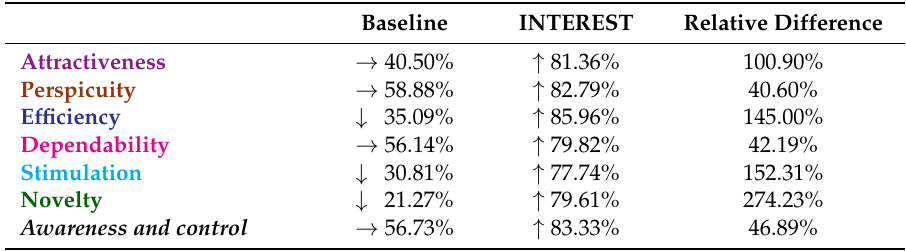
Table 6. Post-task questionnaire results in a [0, 100] scale with relative difference between Baseline and INTEREST on UX factors. The colored arrows have the same meaning as in Table